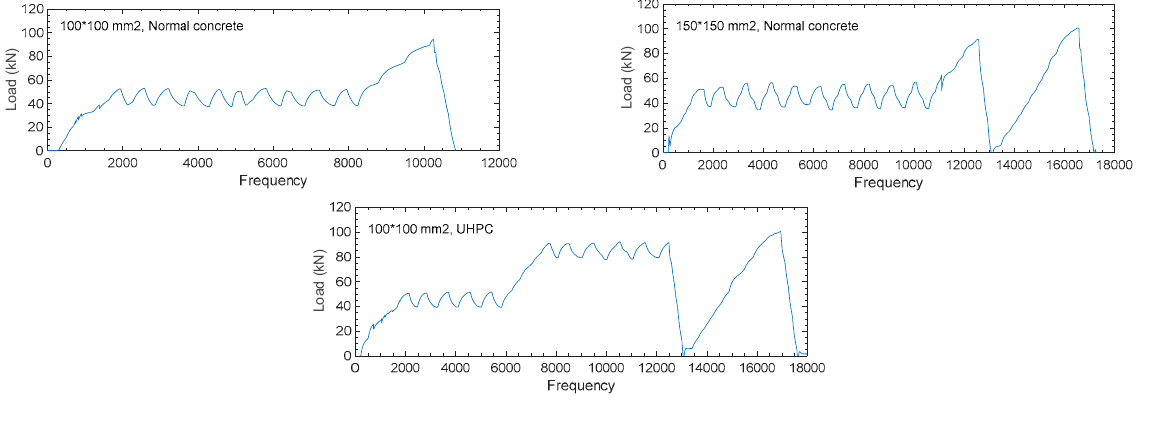
Figure 8. Load sequences for: (1) 100 × 100 mm 2 —Normal concrete, (2) 150 × 150 mm 2 —Normal concrete, and (3) 100 × 100 mm 2 —HPC.